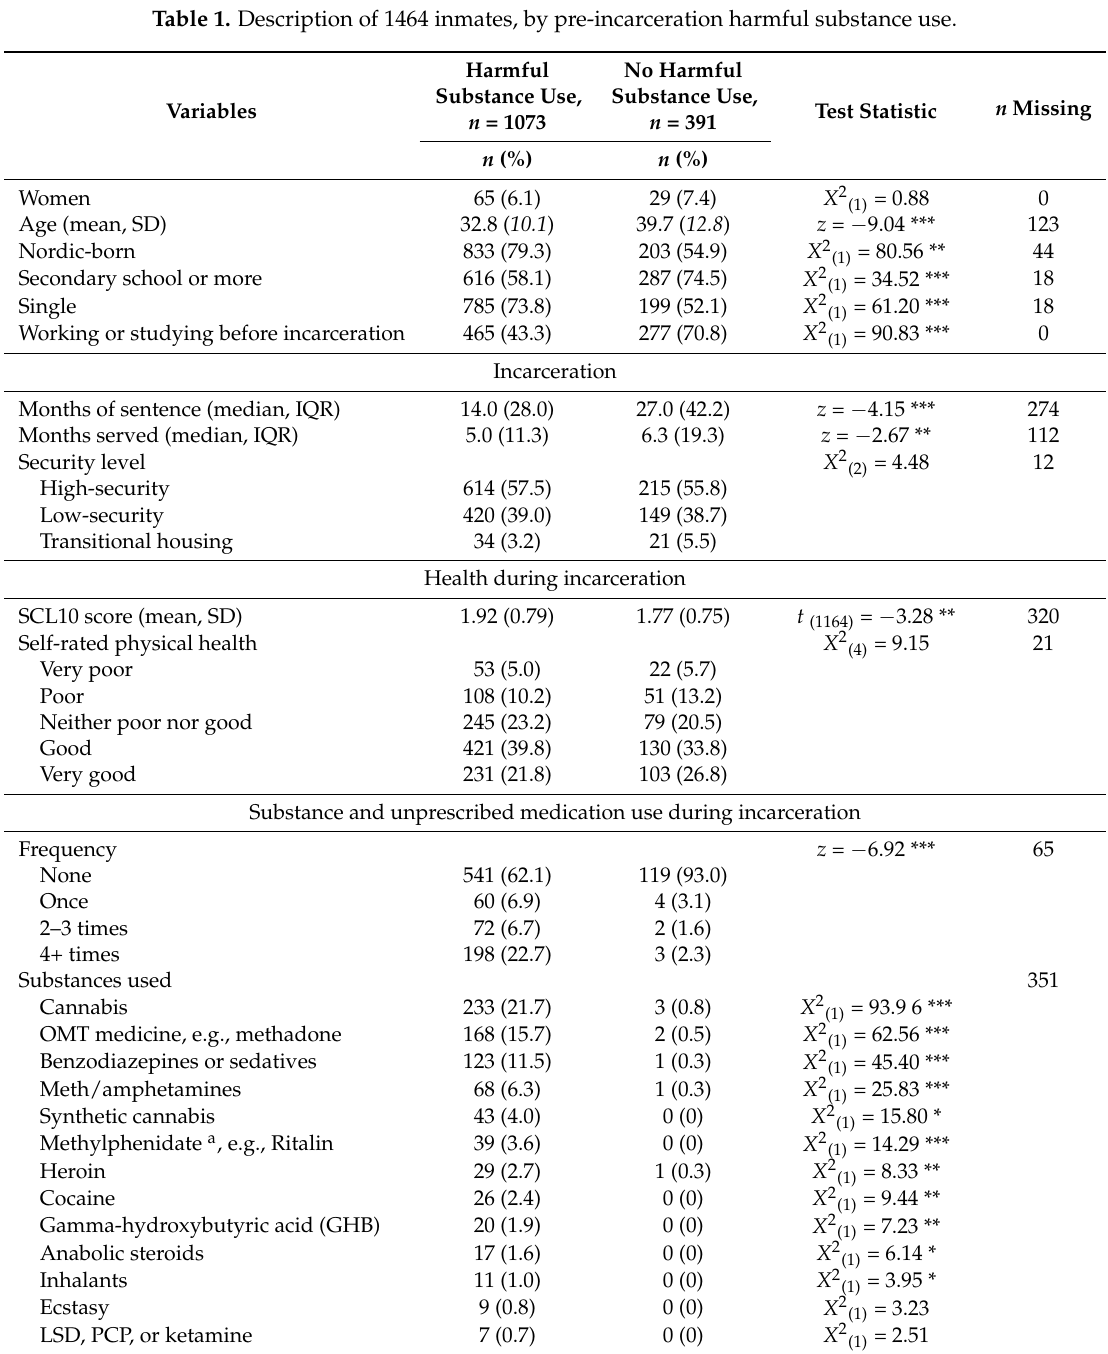
Table 1. Description of 1464 inmates, by pre-incarceration harmful substance